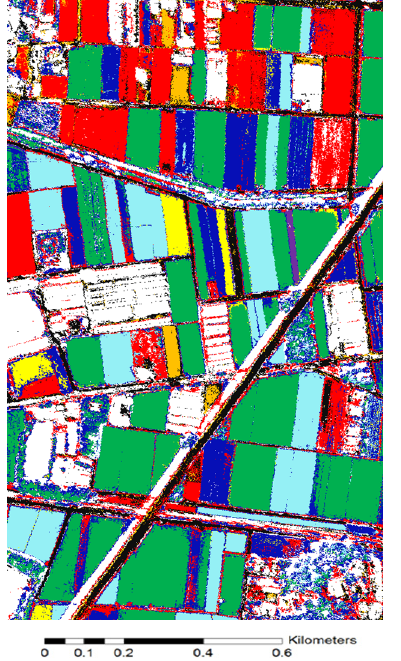
Figure 5. Thematic map of the first stage on SVM.